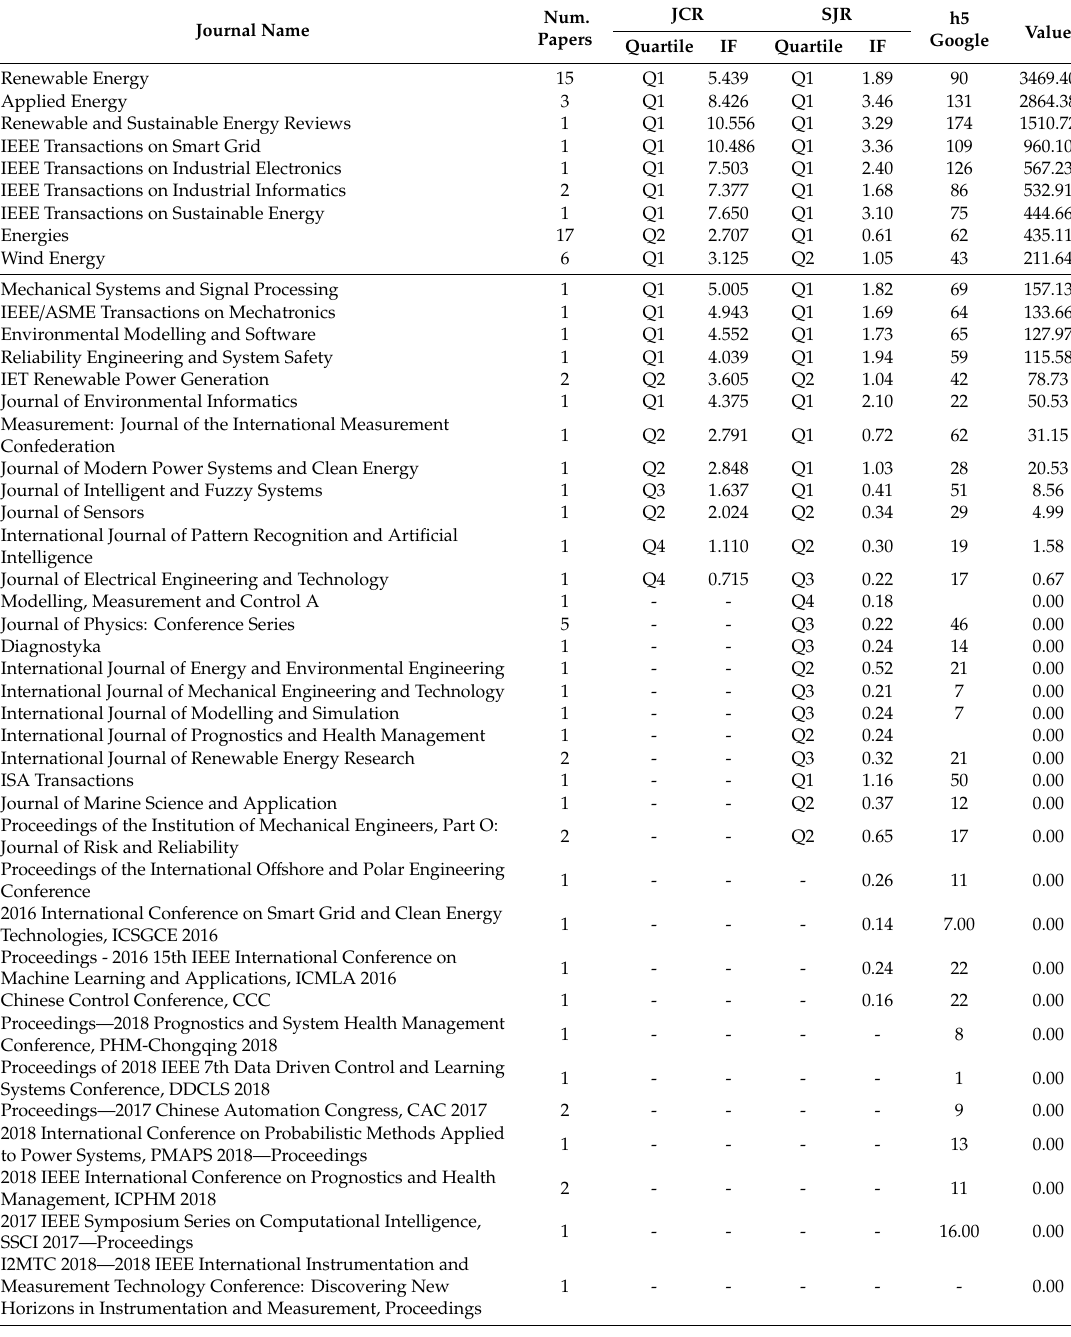
Table 4. List and metrics of journals